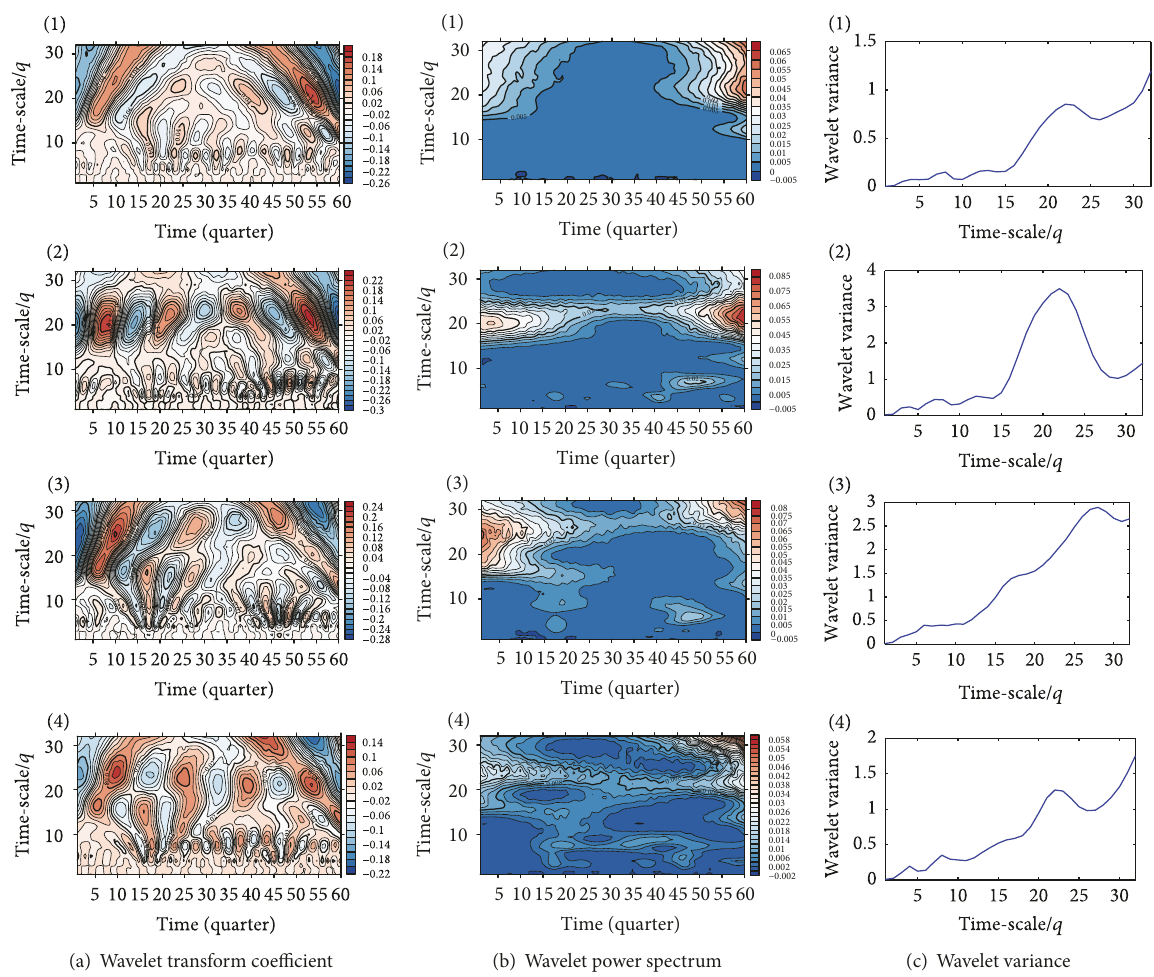
Figure 6: Time-frequency structures of wavelet transform coefficient (a), wavelet power spectrum (b), and wavelet variance (c) of the four select measures ( (1) Node count , (2) Component size , (3) Clustering coefficient , and (4) Clique count ). The blue areas in (a) and (b) correspond to negative wavelet transform coefficients, while red areas show regions with positive wavelet transform